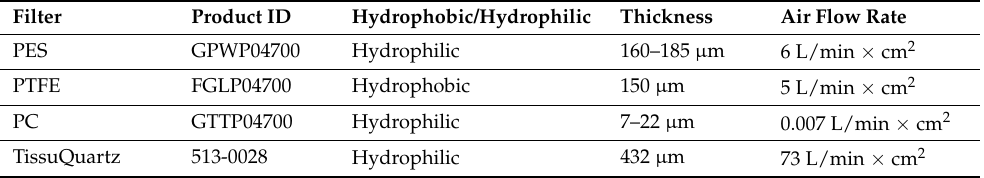
Table 2. Specifications of the filter used in this study.